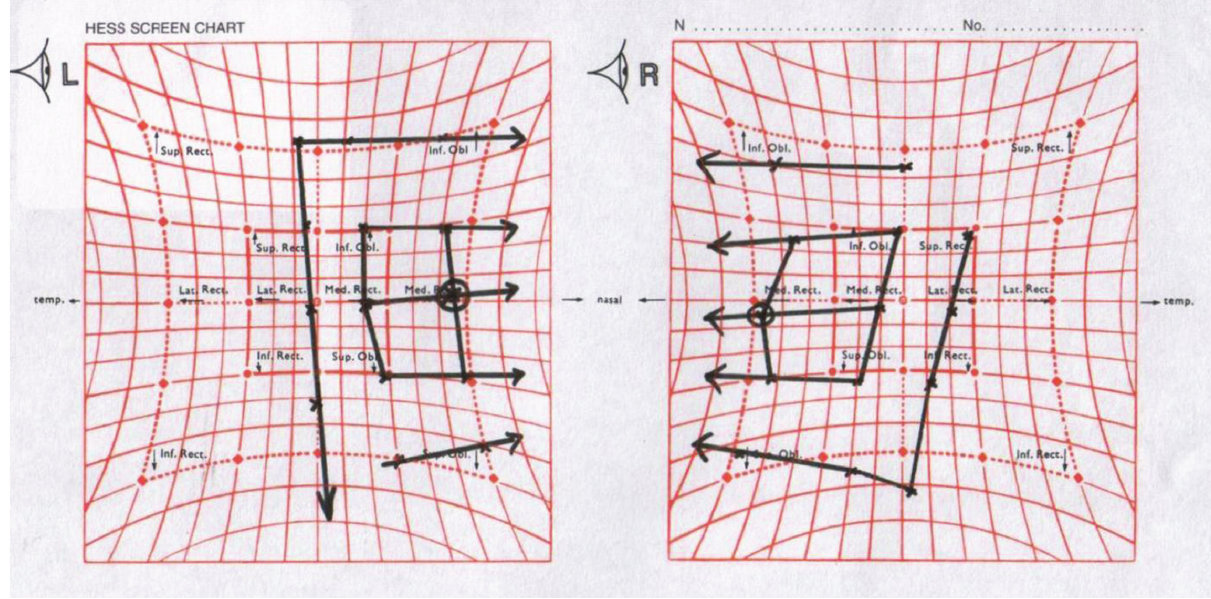
Figure 10: Hess chart showing bilateral fourth and sixth nerve